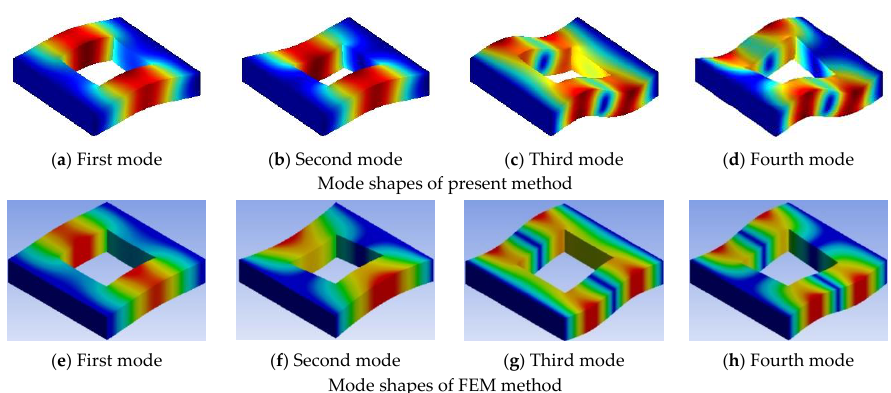
Figure 5. First four mode shapes of (45°/−45°/45°/−45°) laminated square plate with CFCF boundary condition for a cutout size ratio of 0.5.